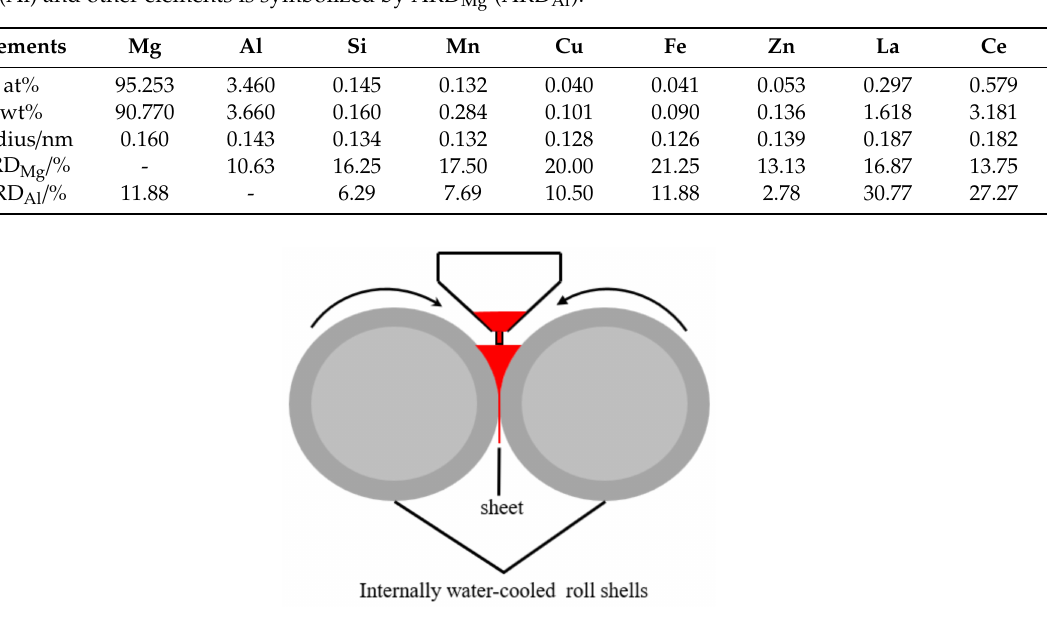
Table 1. Composition and the atomic radius of the Mg-RE alloy (atomic radius di ff erence between Mg (Al) and other elements is symbolized by ARD Mg (ARD Al ).